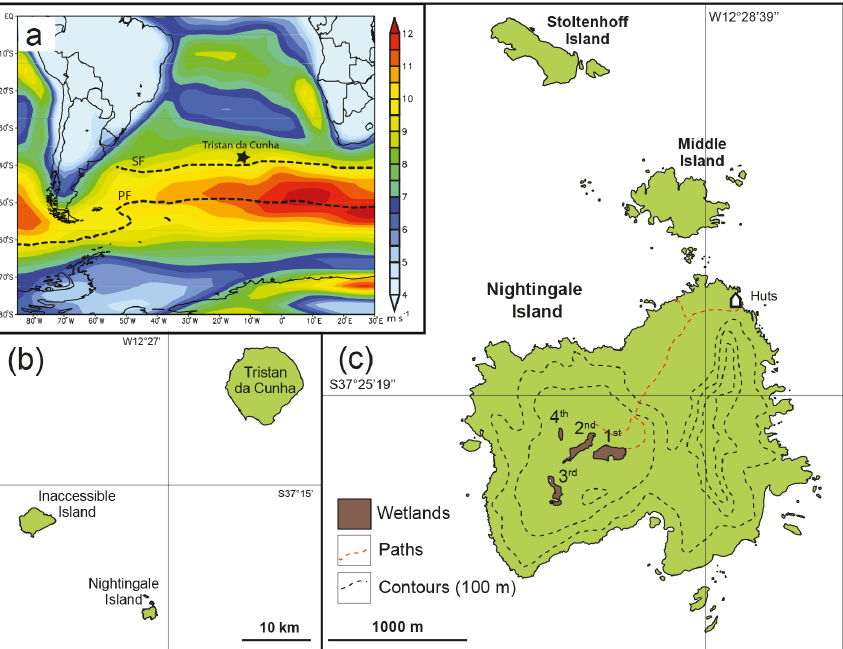
Figure 1. (a) The position of the Tristan da Cunha island group in the South Atlantic and the 1000mbar mean annual wind speed (ms − 1 ) for 1980–2010 according to NCEP/NCAR reanalysis data showing yellow to red colors for the zone of the Southern Hemisphere westerlies, and the positions of the Subtropical Front (SF) and the Polar Front (PF) as dashed lines. (b) The three main islands of the Tristan da Cunha island group. (c) The position and size of the four overgrown lake basins, so-called ponds (labeled 1P–4P), on Nightingale Island with 100m contour